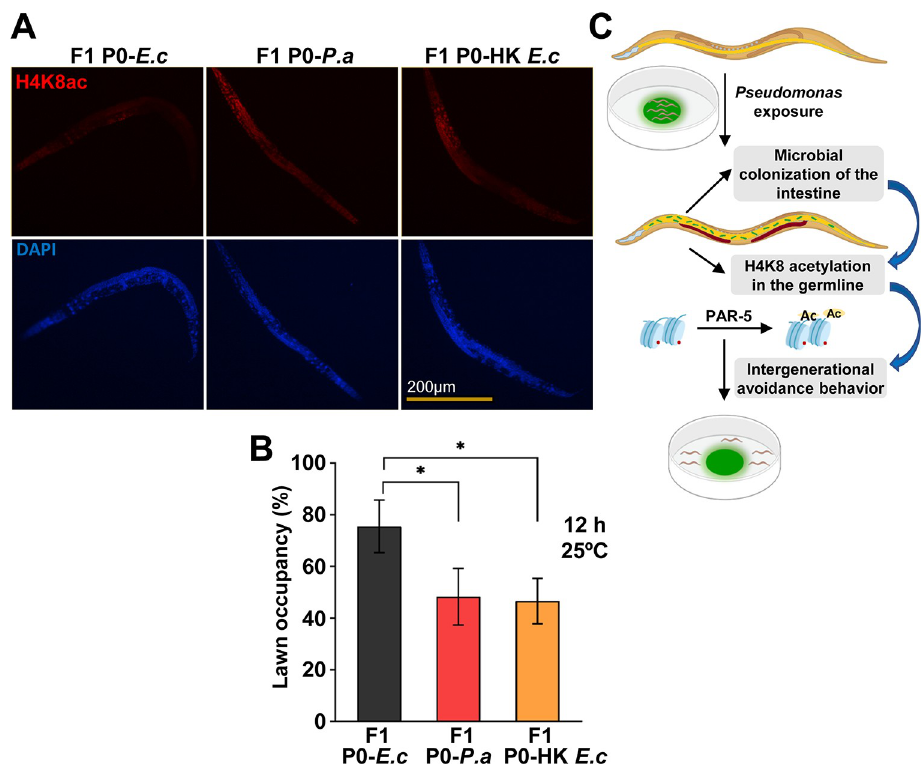
Fig 4. Enhanced H4K8ac in the germline is required for the intergenerational pathogen avoidance. (A) Whole- mount immunofluorescence using an anti-H4K8ac antibody to strain F1 wild-type N2 young adults from P0 animals exposed to E . coli ( E . c ), P . aeruginosa ( P . a ), or heat-killed E . coli (HK E . c ) starting at the L4 stage for 24 hours. (B) Lawn occupancy of F1 wild-type N2 animals at 12 hours from P0 animals exposed to E . coli ( E . c ), P . aeruginosa ( P . a